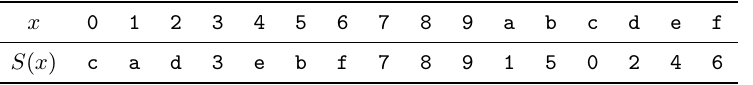
Table 3: The S-box of MIDORI and CRAFT